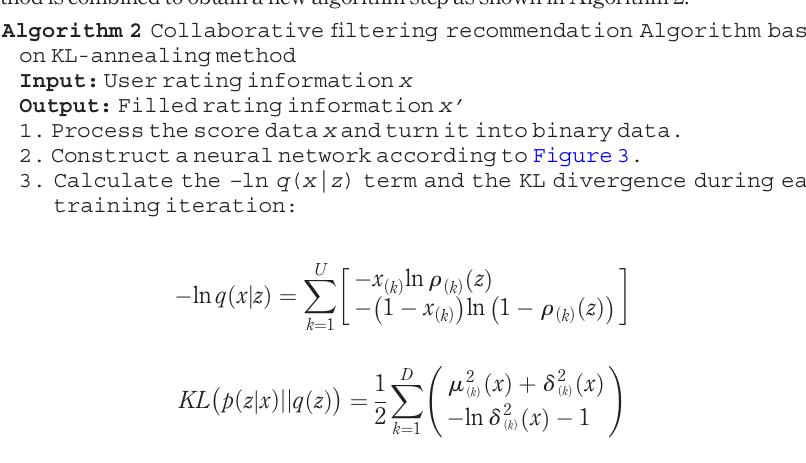
Algorithm 2 Collaborative fi ltering recommendation Algorithm